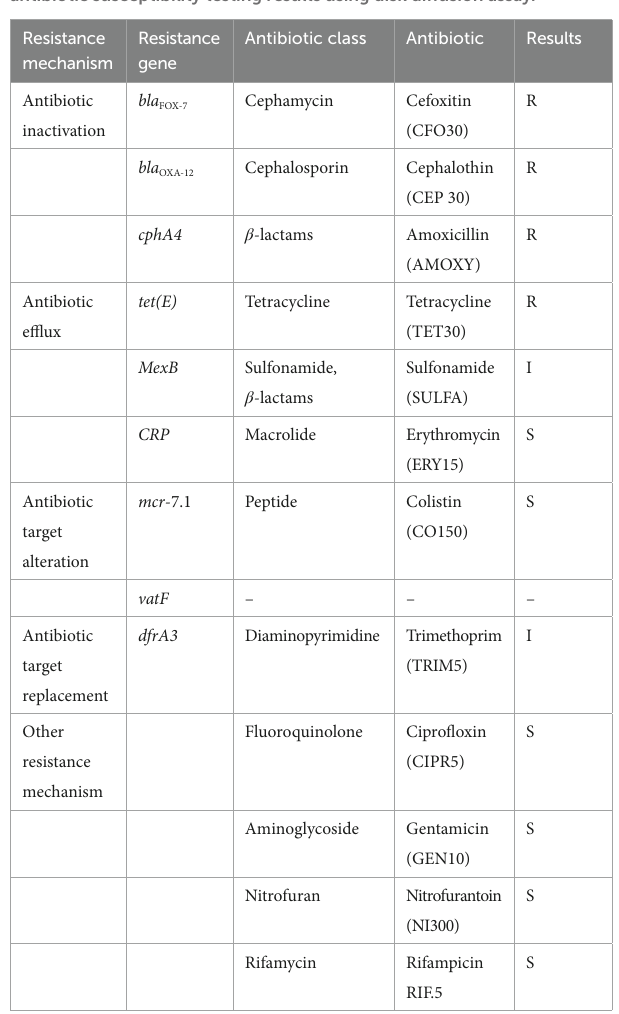
Table 1 Overview of antibiotic resistence genes detected in the draft genome of Aeromonas veronii AhS5-24 together with phenotypic antibiotic susceptibility testing results using disk diffusion